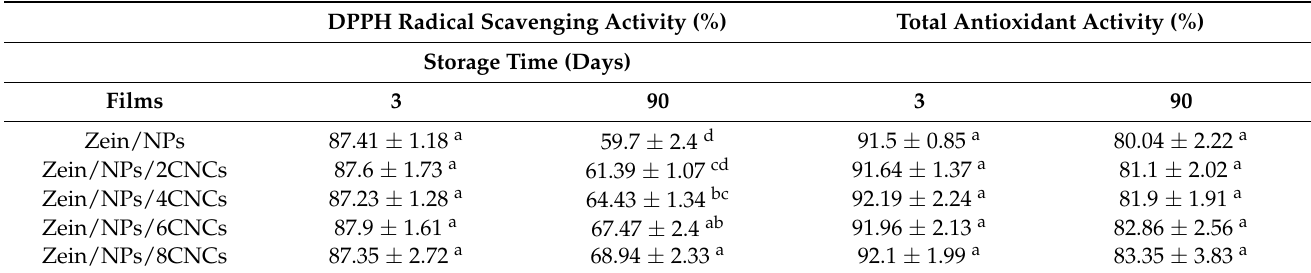
Table 3. DPPH radical scavenging activity and total antioxidant activity of films. DPPH Radical Scavenging Activity (%) Total Antioxidant Activity